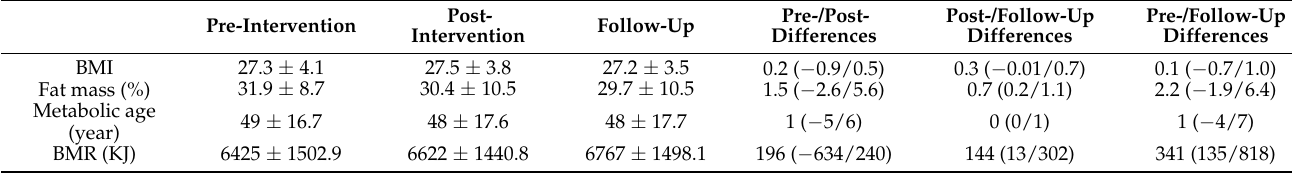
Table 1. Pre-intervention, post-intervention and follow-up mean score changes of characteristics of the sample. Pre-Intervention Post- Intervention Follow-Up Pre-/Post-